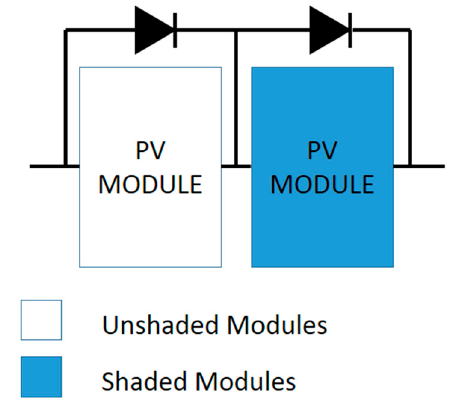
Figure 22. Photovoltaic string consisting of two photovoltaic modules.